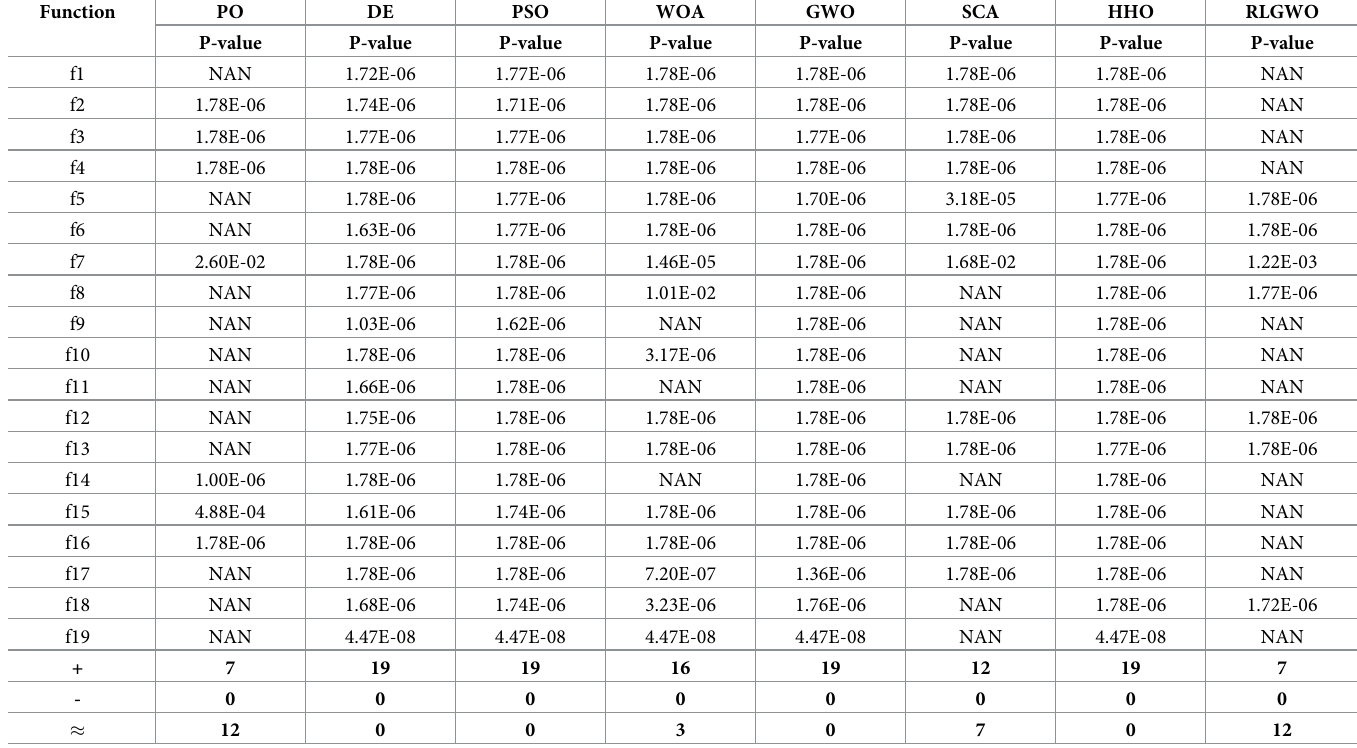
Table 7. p-values of the Wilconxon rank-sum test at 0.05 significance level for CRLPO against other eight algorithms on 19 benchmark functions from table 1 with 1000 dimensions.